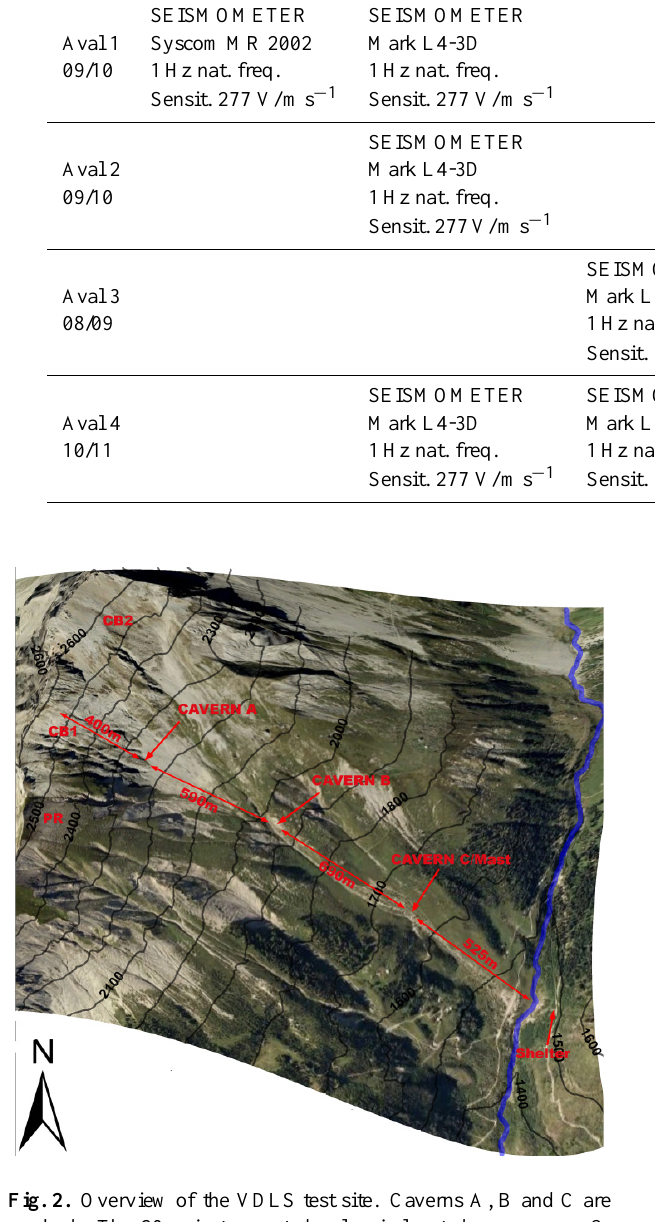
Fig. 2. Overview of the VDLS test site. Caverns A, B and C are marked. The 20m instrumented pylon is located near cavern C. PDR and the VDLS data acquisition systems are located in a shelter opposite the slope. Release areas are indicated as Pra Roua (PR), Crˆeta-Besse 1 (CB1) and Crˆeta-Besse 2 (CB2). The La Sionne river is shown in blue (source: Google